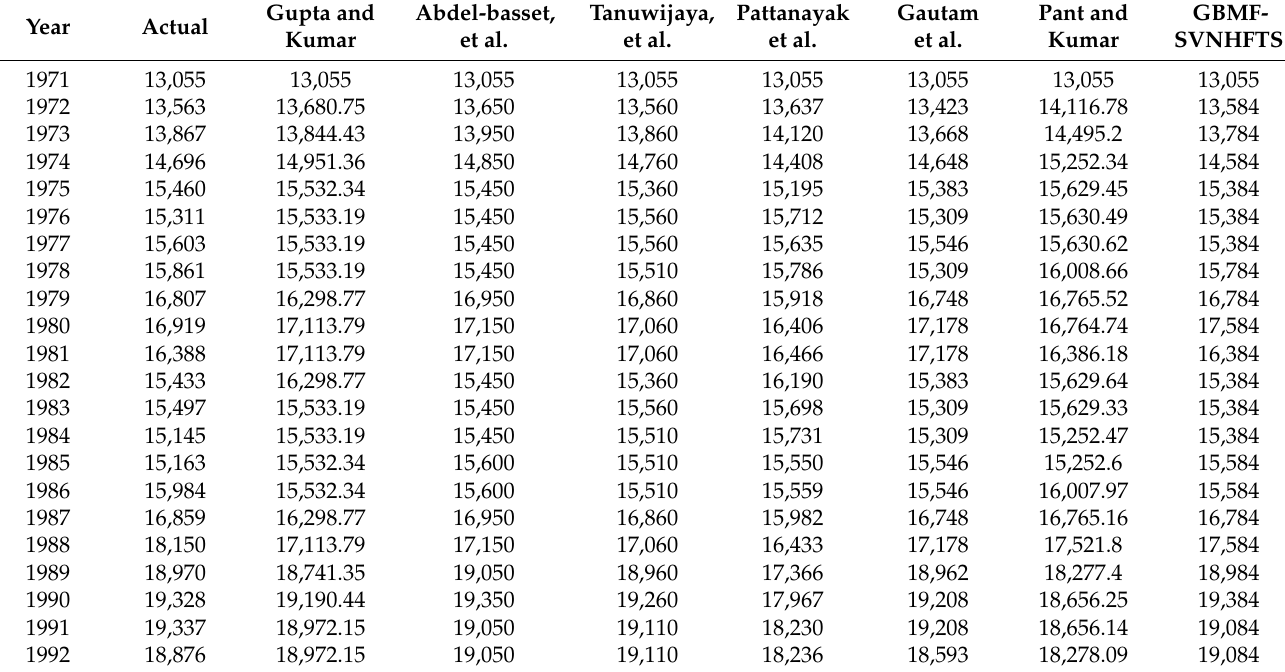
Table 1. A comparison of the forecasted results of the other FTS methods with the proposed GBMF- SVNHFTS.